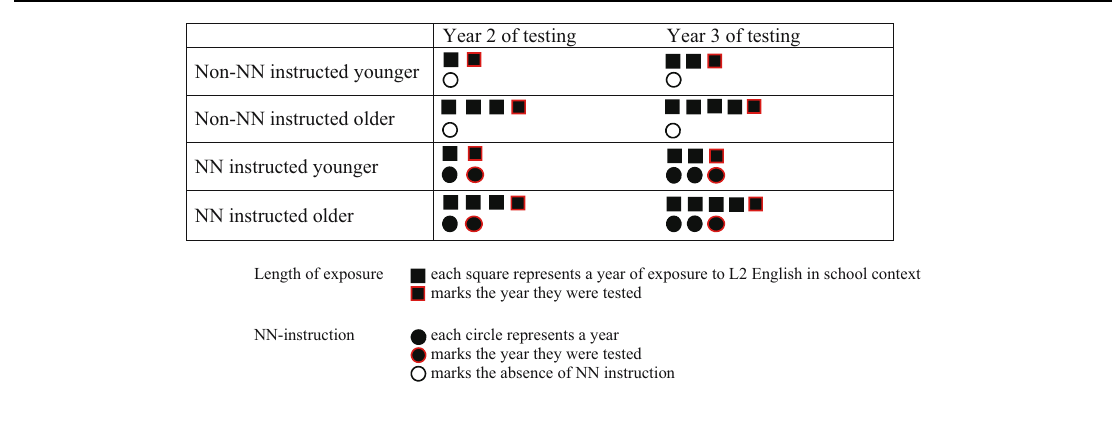
Table 2: Longitudinal study: length of exposure and NN